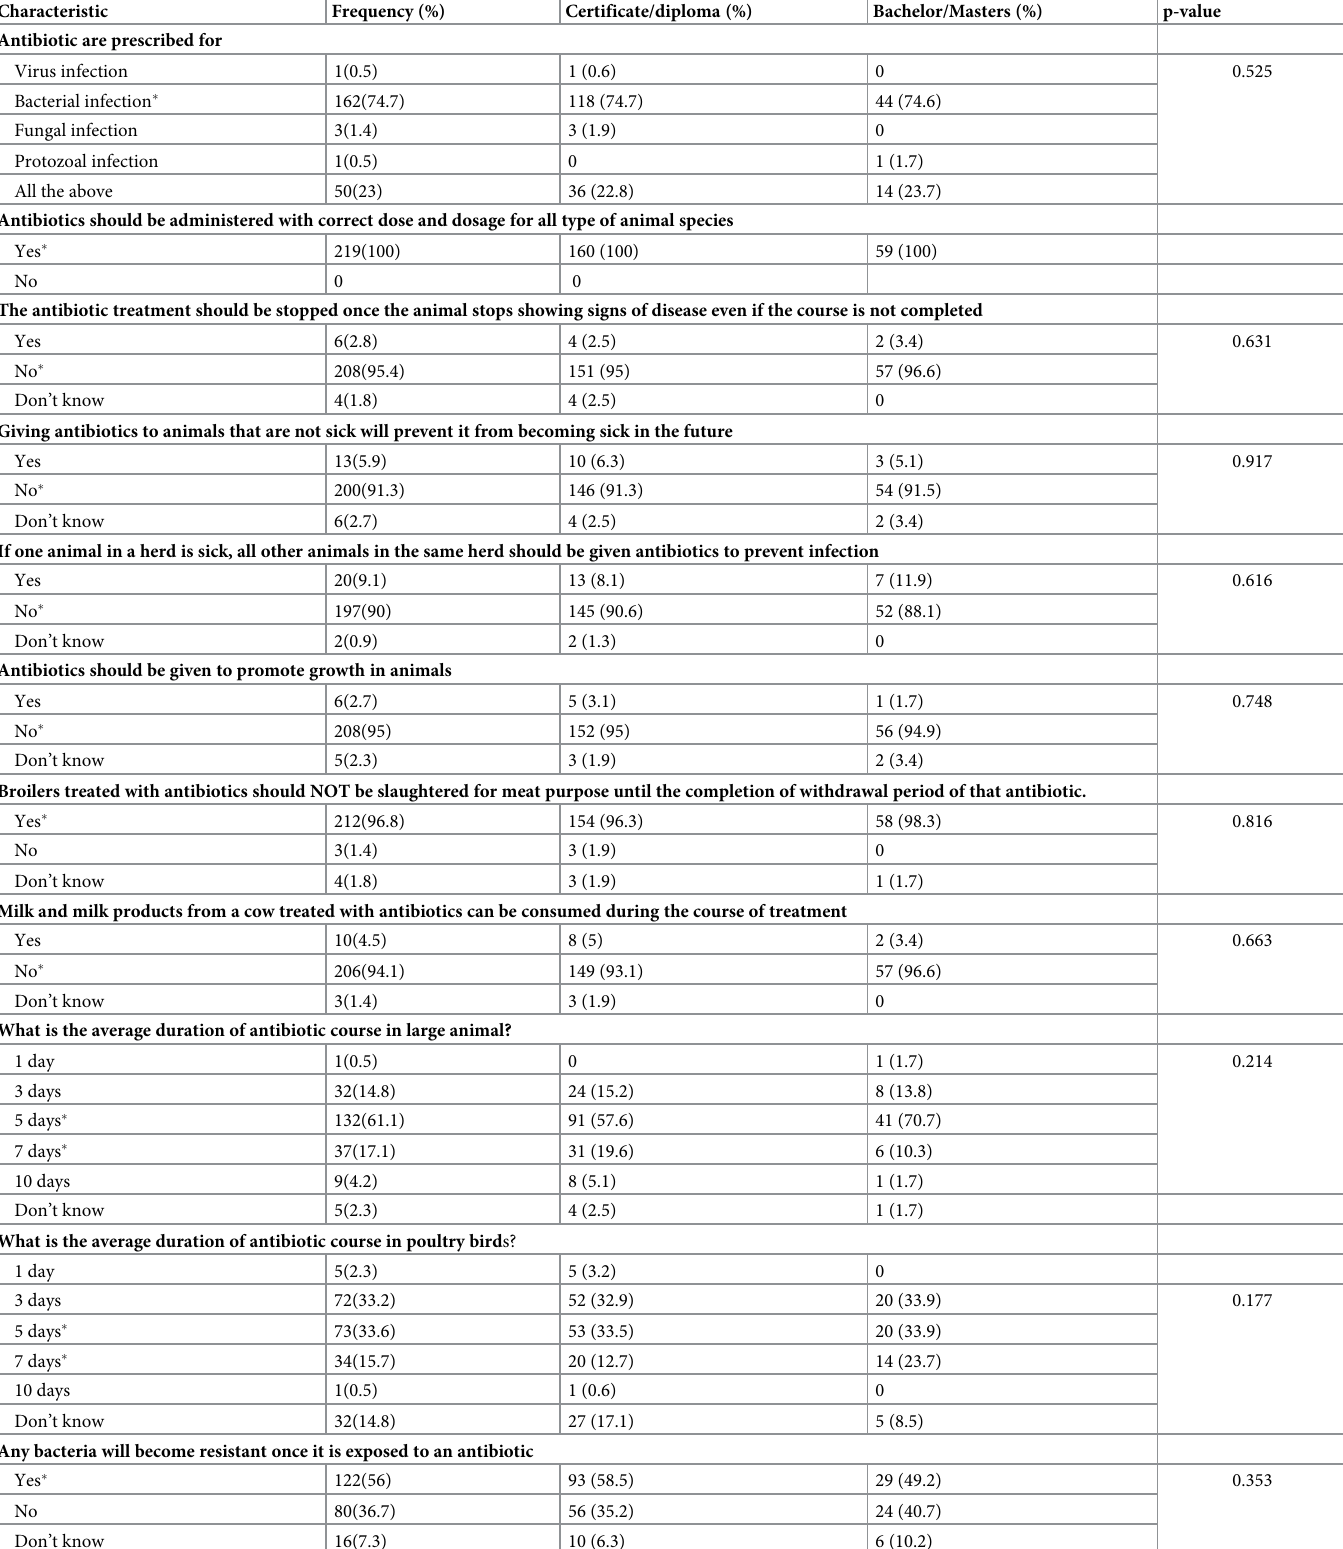
Table 2. Knowledge on antibiotic use and AMR among the veterinarians and para veterinarians.